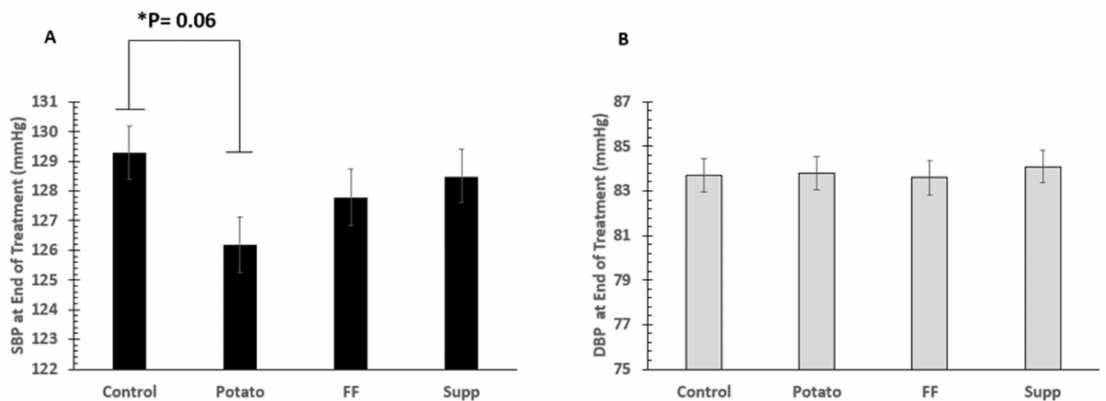
Figure 4. Primary BP outcome: comparison of end-of-treatment ( A ) systolic blood pressure (SBP) and ( B ) diastolic blood pressure (DBP) for all intervention phases with an adjustment for baseline